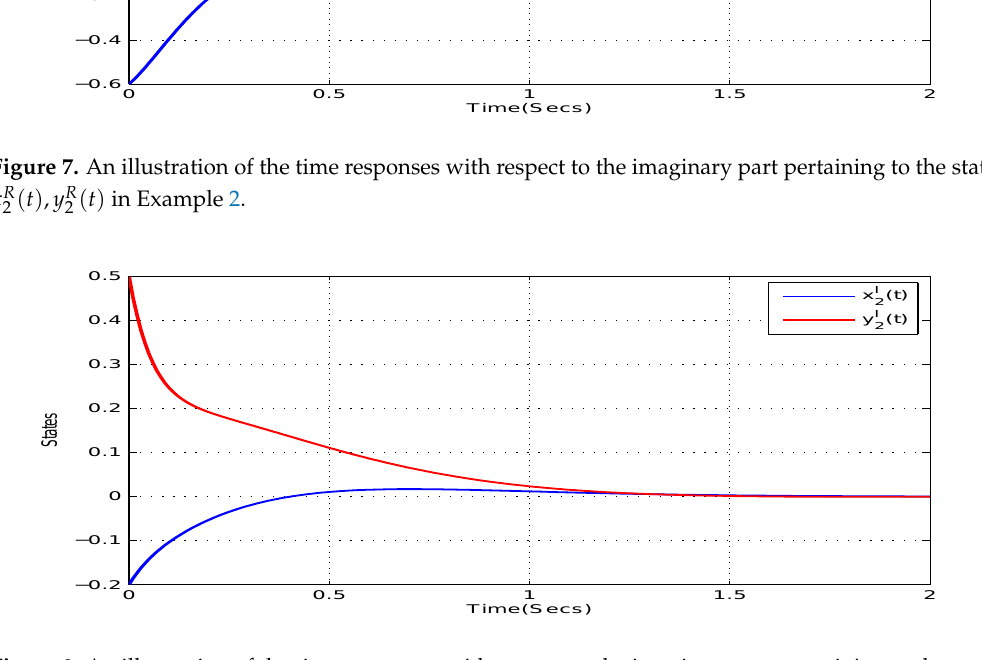
Figure 8. An illustration of the time responses with respect to the imaginary part pertaining to the states of ( t ) in Example 2. ( t ) , y I x I 2 2